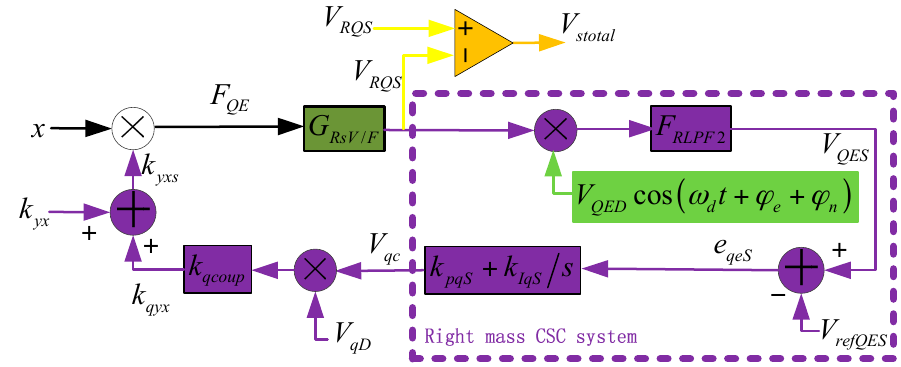
Figure 11. Right mass SCS system.